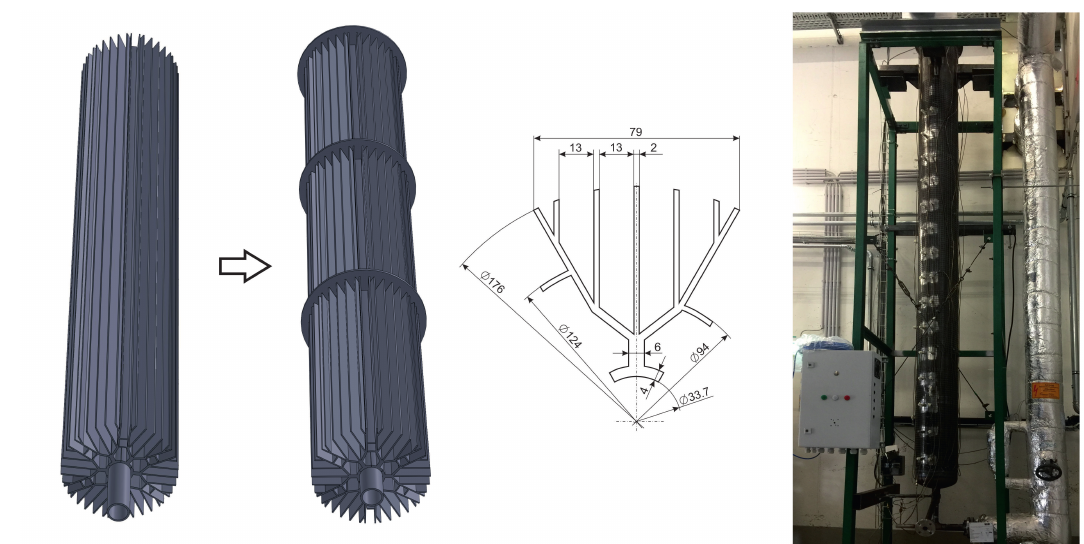
Figure 2. Novel fin geometry with profile dimensions and a picture of the uninsulated test